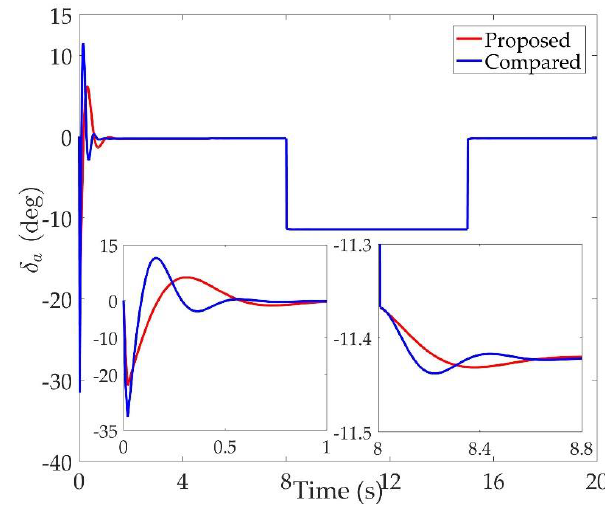
Figure 8. Comparison curves of the left elevon.